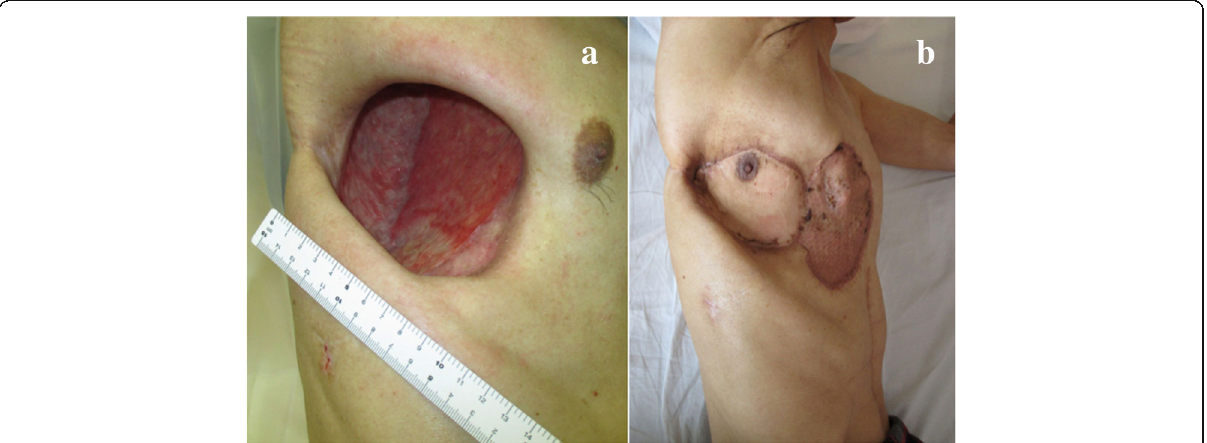
Fig. 3 The window is simply closed with a pectoralis major flap without obliteration of the cavity ( a ). Split-thickness skin graft obtained from the thigh covers the area where the pectoralis major was harvested ( b